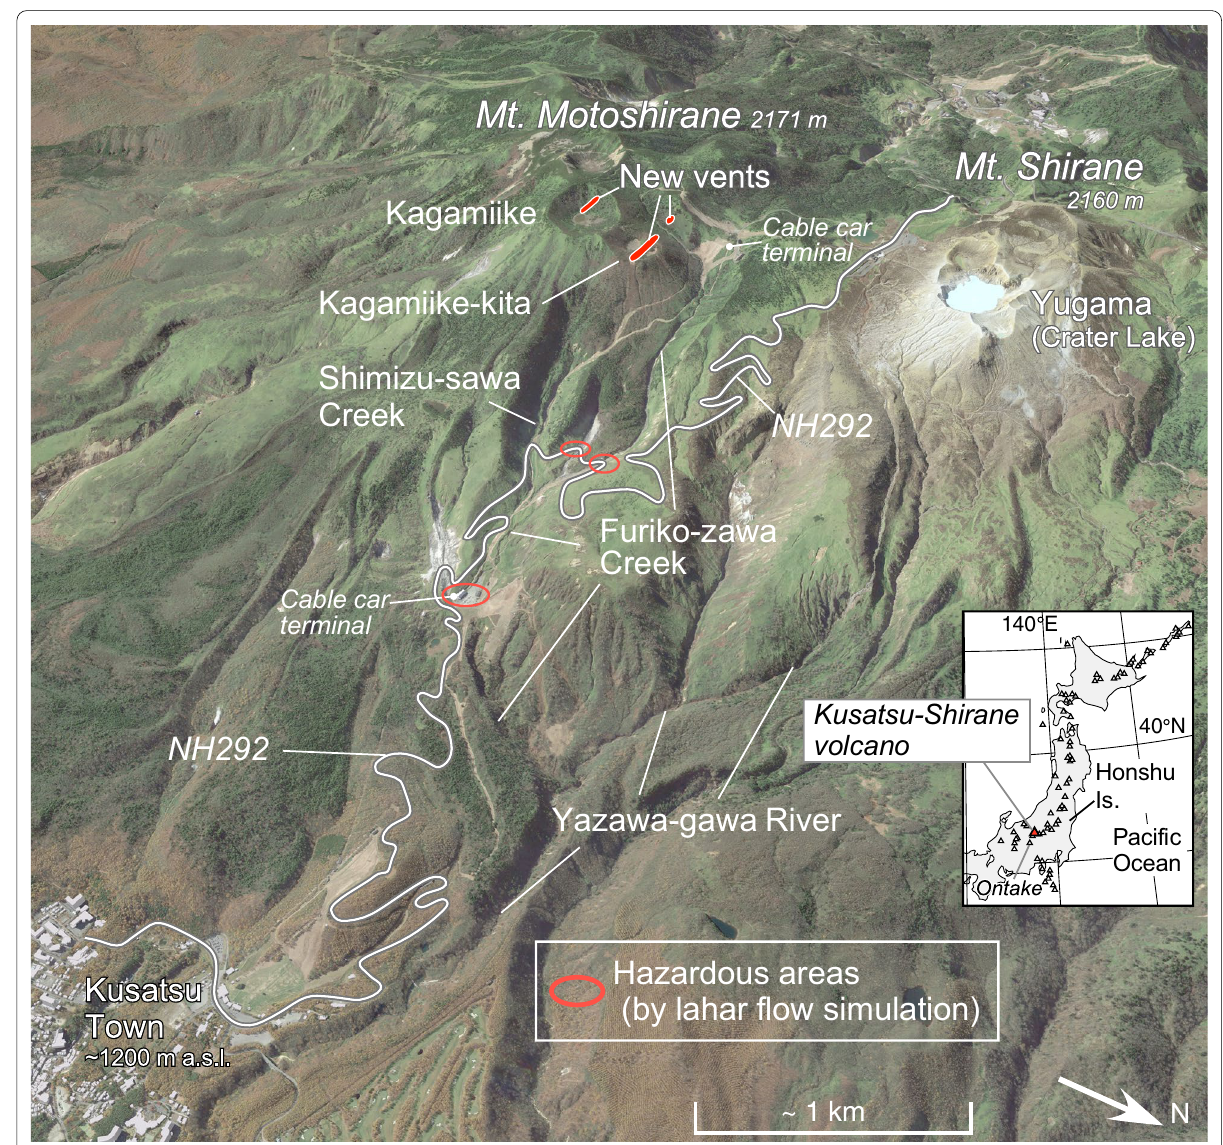
Fig. 1 Oblique view on the Google Earth ® map of Kusatsu-Shirane volcano including Mts. Motoshirane (middle) and Shirane (right), looking the eastern side of the volcanic edifice and Town of Kusatsu (downslope). Red circles indicate high-risk areas in the 2018 eruption crisis recognized by the lahar flow simulations in this